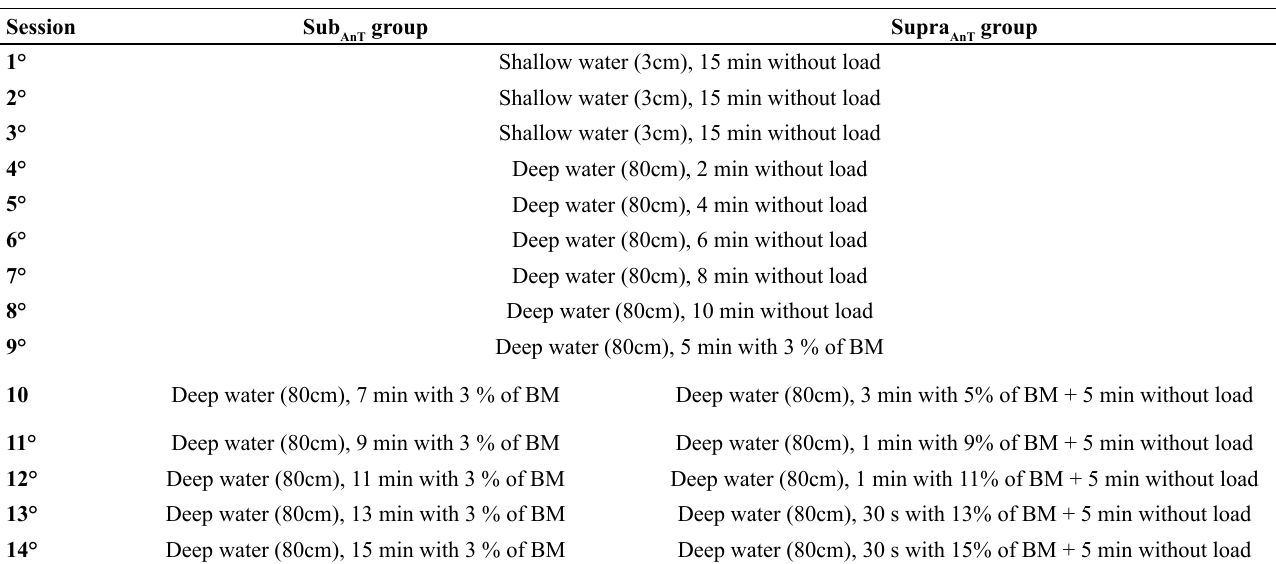
Table 1. Water environment adaptation protocols applied throughout the extent of the